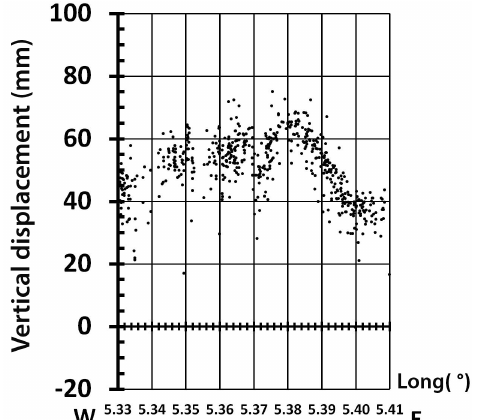
Figure 8. Variation of the total surface movement along a east–west transect, situated for a latitude between 51.018 and 51.026 ◦ N for the 5-year time zone in Period 2 (from mid-September 2005 through mid-September